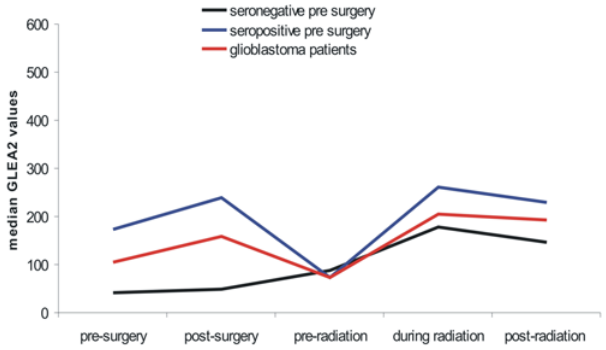
Figure 3. Main course of GLEA2 seroreactivity. Line plot of median GLEA2 values on the five measurement times. The median values of all 24 glioblastoma patients (red line) were compared to two patient subgroups. Patients that were GLEA2 positive prior to surgery were indicated by blue line. Patients that were GLEA2 negative prior to surgery were indicated by black